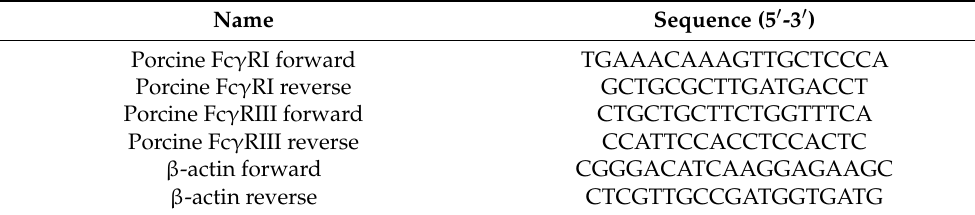
Table 4. The sequences of relative quantitative RT-PCR